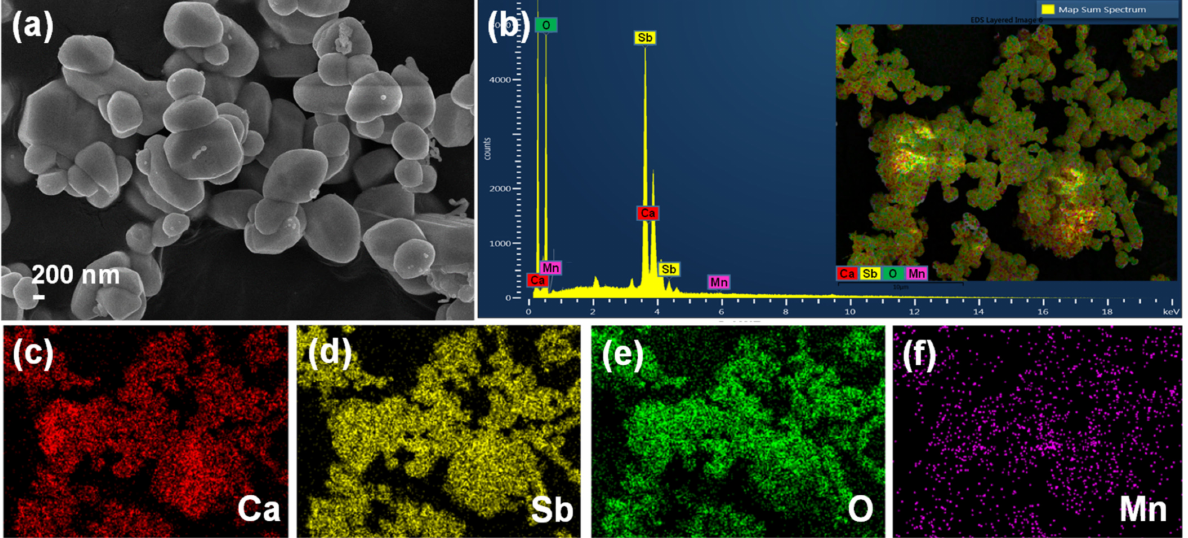
Figure 1. ( a ) FE-SEM image, ( b ) EDX spectrum, and elemental mapping of elements ( c ) Ca, ( d ) Sb, ( e ) O, ( f ) Mn. Inset of ( b ) shows a layered image of all the elements present in the sample. The XRD pattern of the CSO: 2Mn 4+ sample is shown in Figure 2a. The XRD pattern shows sharp diffraction peaks with major peaks at 2 θ values of 17.62 ◦ , 19.53 ◦ , 26.44 ◦ , 34.17 ◦ , 38.71 ◦ , and 50.27 ◦ which corresponds to (001), (100), (101), (110), (2-11), and (2-12) planes, respectively, with other minor peaks at higher 2 θ values. All the diffraction peaks of the sample match well with the standard JCPDS card #46-1496. The results show the sample crystallized in a hexagonal system with a space group of P -3 1 m (162). The lattice parameters of the sample are a = b (Å): 5.24, c (Å): 5.02, and V (Å 3 ): 119.42